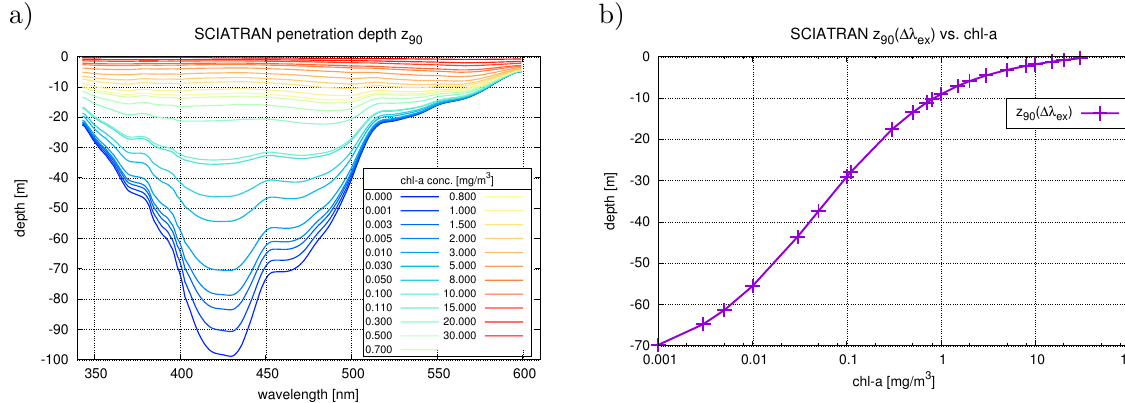
Figure 3. (a) Spectral resolved attenuation depth z 90 expressed by E d (λ,z 90 ) = E d (λ, 0 − ) · e − 1 for different chl a . (b) The averaged attenuation depth z 90 ((cid:49)λ ex ) for the VRS excitation wavelength region 390–444.5nm vs. chl a